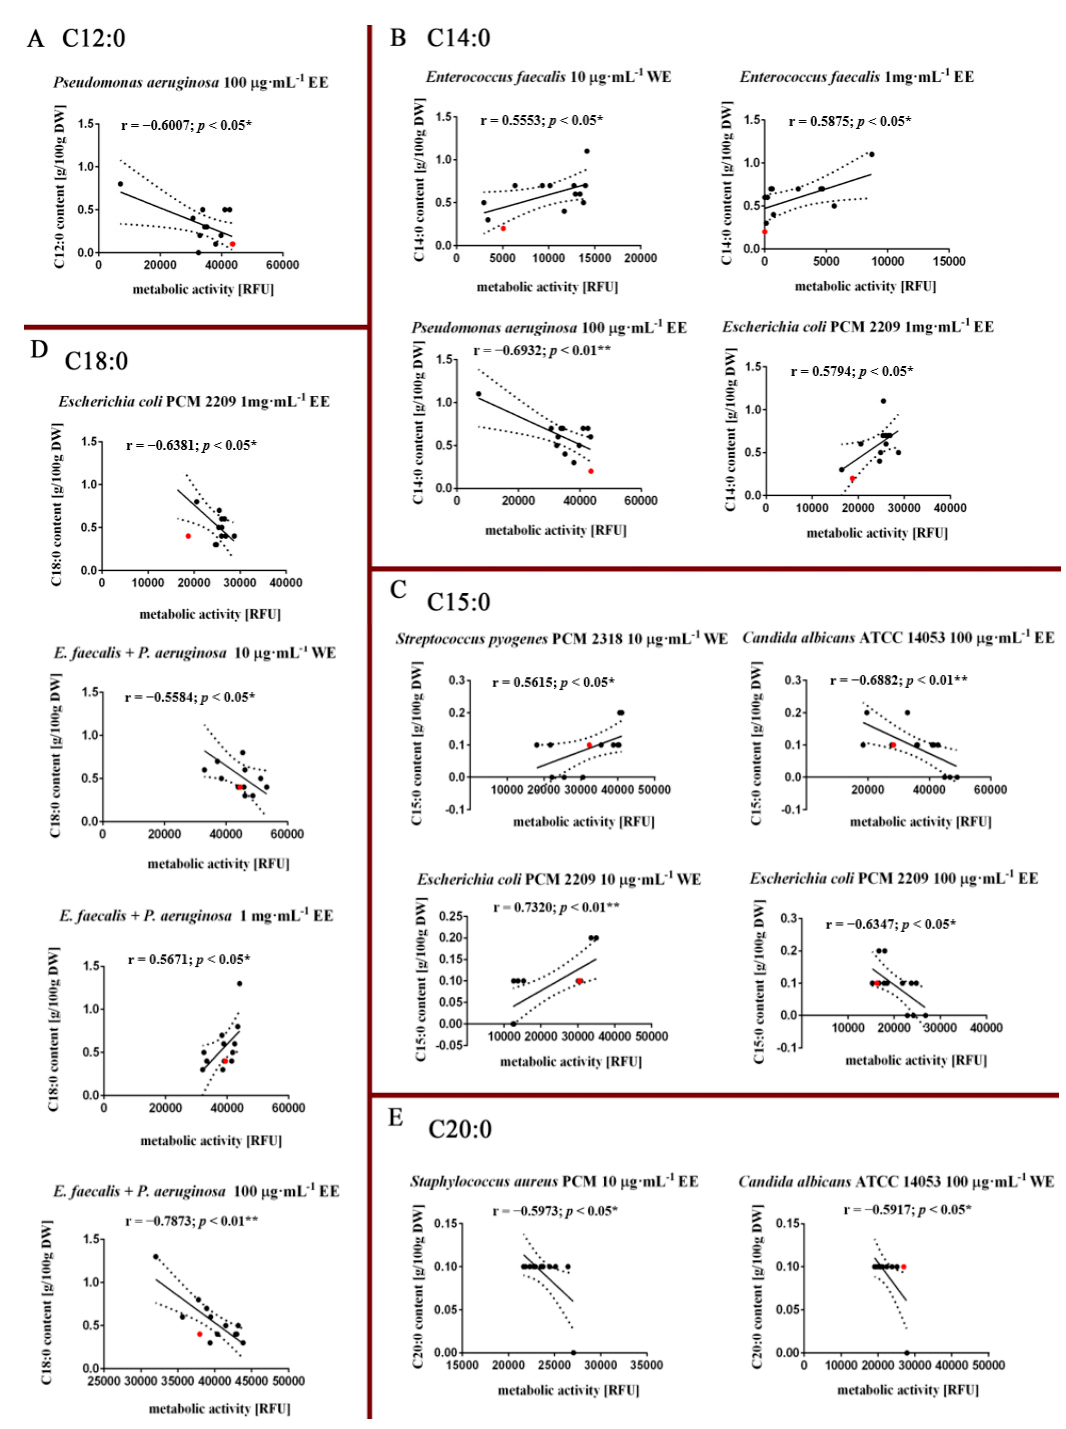
Figure 4. Fatty acid-mediated effect on the metabolic activity of selected bacterial species: Streptococcus pyogenes PCM 2318, Staphylococcus aureus PCM 458, Pseudomonas aeruginosa , Escherichia coli PCM 2209 and Candida albicans ATCC 14053. Correlation analysis between ( A ) Lauric acid (C12:0), ( B ) Myristic acid (C14:0), ( C ) Pentadecylic acid (C15:0), ( D ) Stearic acid (C18:0) and ( E ) Arachidic acid (C20:0) ratio and metabolic activity (RFU). Twelve CC-treated clones were considered (black dots). WT cells are indicated with a red dot. Results represent the mean from three independent experiments. The levels of fatty acids were calculated per g of dry weight. The 95% confidence interval is shown. Correlation analysis of the data was performed using a Linear Correlation (Pearson r) test. DW, dry weight.